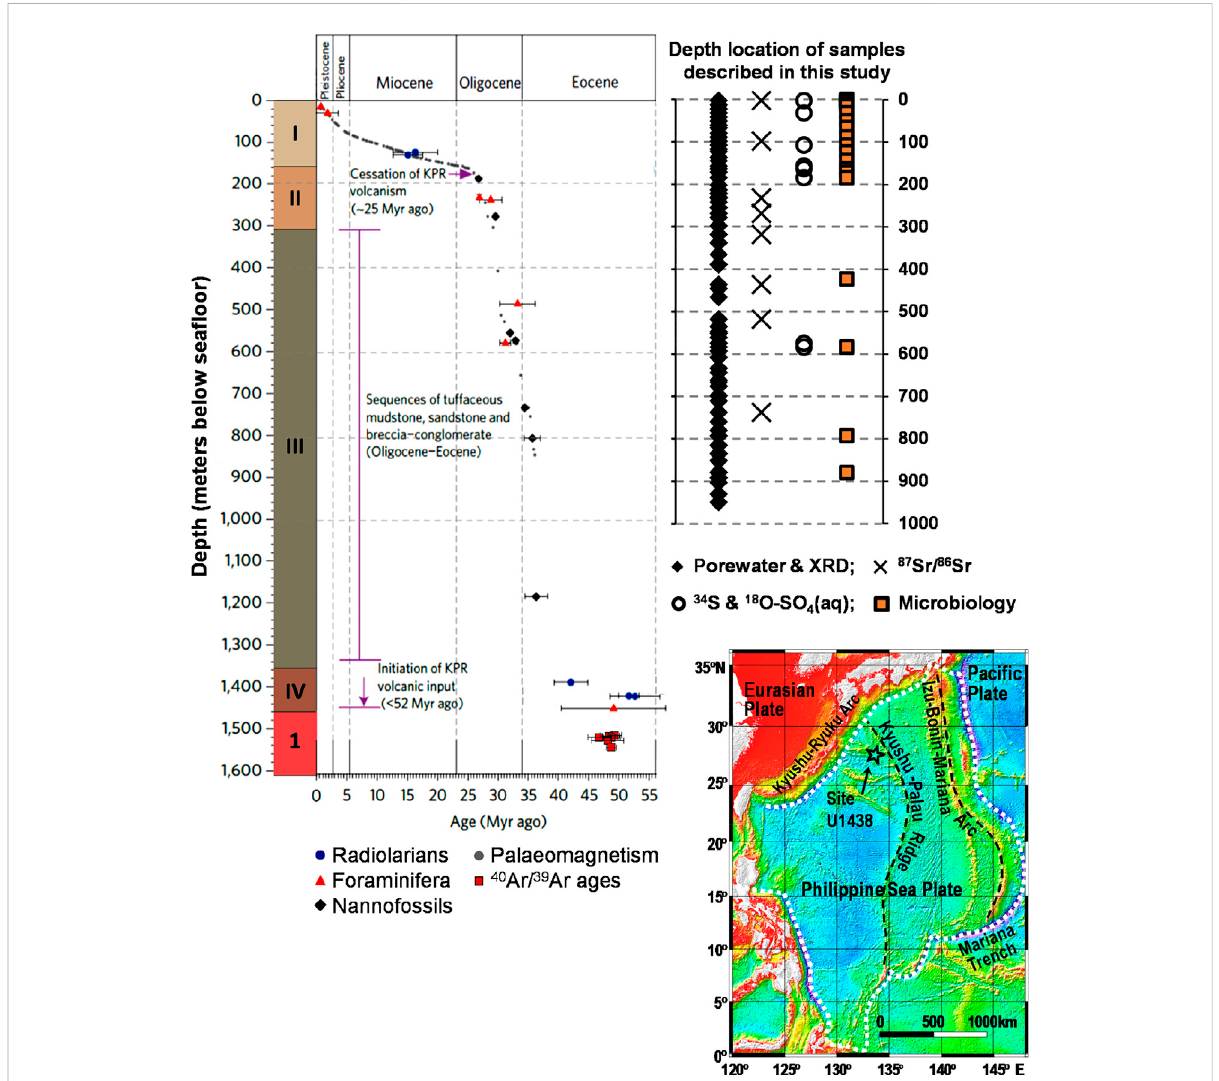
FIGURE 1 Lithostratigraphy of IODP Site U1438 and depth location of the samples described in this study. Lithostratigraphic units described in the main text. Insert is a bathymetric map with location of Site U1438 (red < 100 m, purple > 10,000 m). Image with age-depth model modi fi ed from Arculus et al. (2015b). Radiometric ( 40 Ar/ 39 Ar) ages of the oceanic crust from Ishizuka et al.